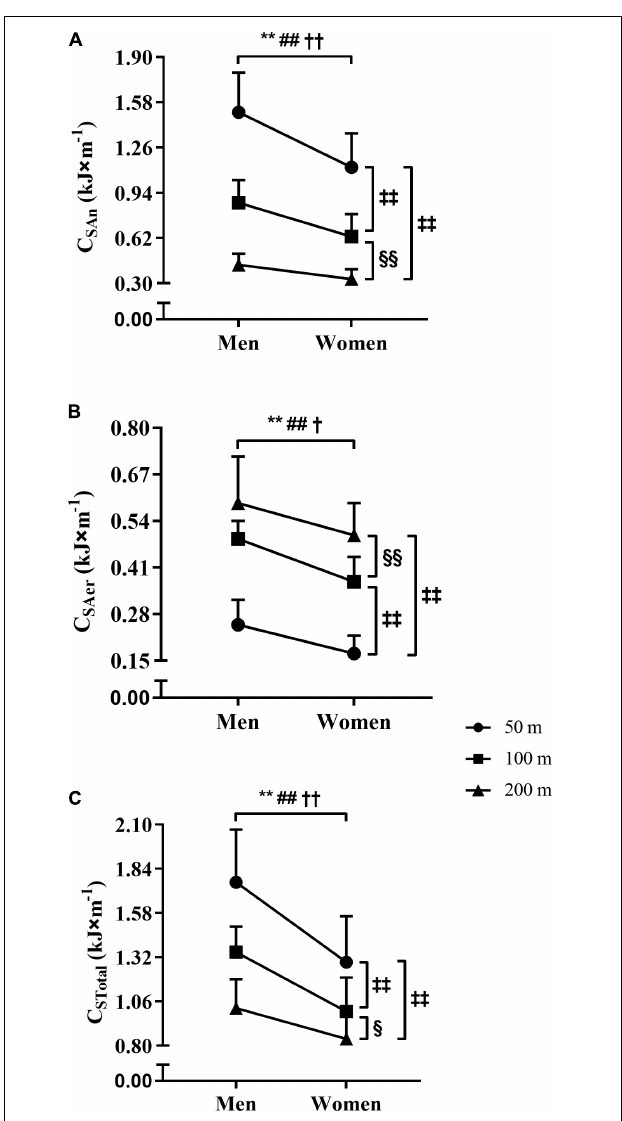
FIGURE 4 | The comparisons of C An , C Aer , and C Total values (A–C) between the sexes and distances. Obs.: The acronyms C An , C Aer , and C Total represent the anaerobic, aerobic, and total costs. Significantly different from men at ρ ≤ 0.05 † in 200 m, and at ρ ≤ 0.01 in 50**, 100 ## , and 200 m †† . Significantly different from 50 m at ρ ≤ 0.01 ‡‡ . Significantly different from 100 m at ρ ≤ 0.05 § and ≤ 0.01